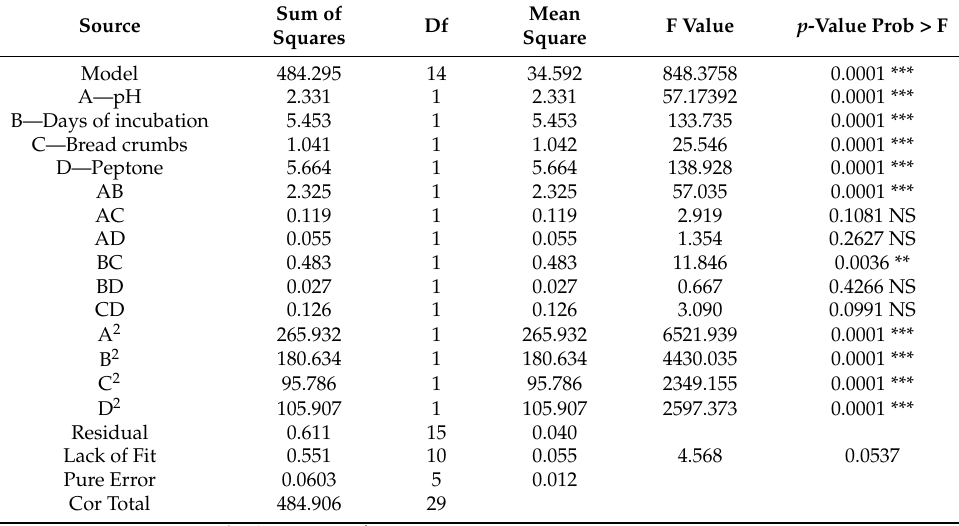
Table 4. Analysis of variance for response of biomass production by Thraustochytrium